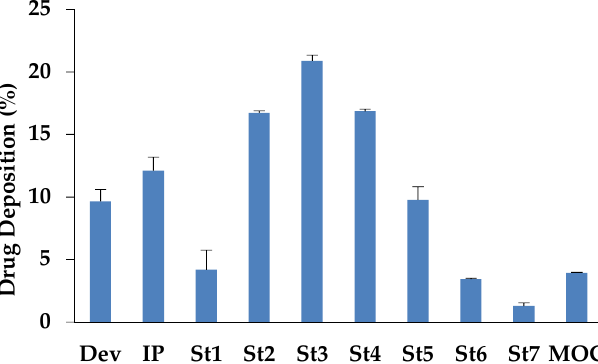
Figure 4. Distribution of CsA_M20 powder on Next Generation Impactor. The loaded amount of powder in the capsule was 20 mg containing 16 mg of CsA, (n = 3, mean value ± SD). Dev = device; IP = induction port; St = stage; MOC = micro-orifice collector.